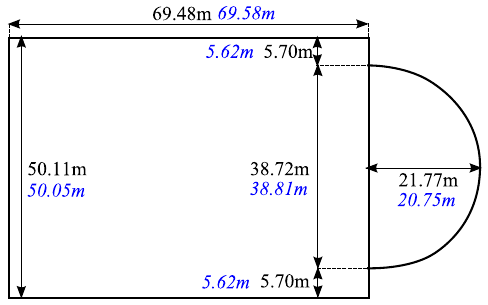
Figure 12. Validations of the close-range photograph case